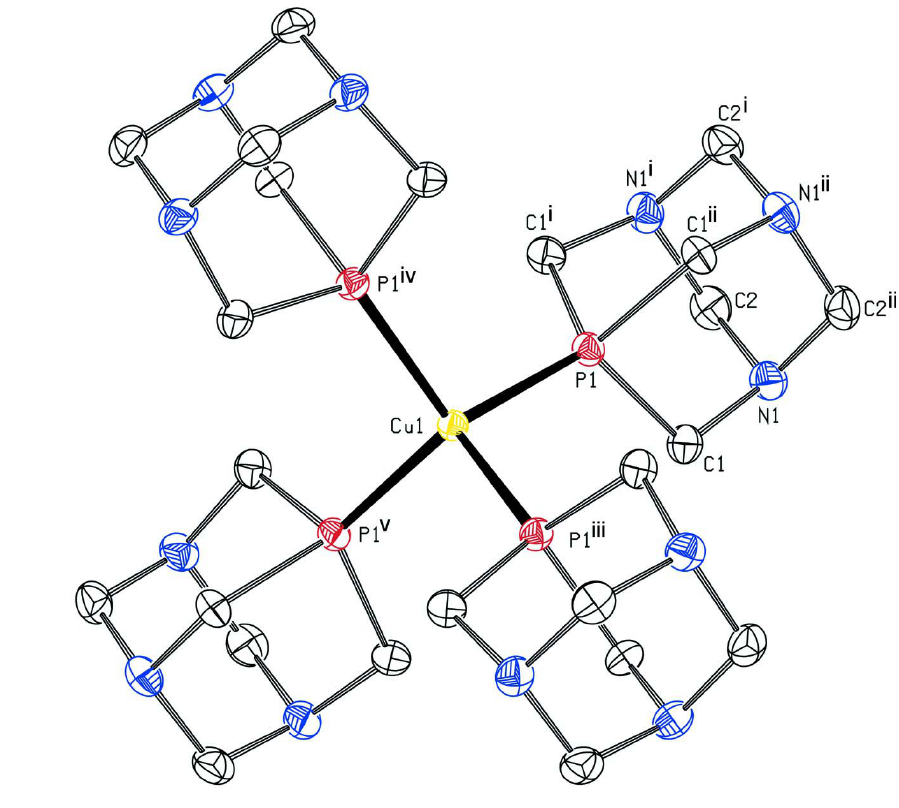
Molecular view of the cation with the atom-labelling scheme. Displacement ellipsoids are drawn at the 50% probability level. Hydrogen atoms are omitted for clarity. [Symmetry codes: (i) z, x, y; (ii) y, z, x; (iii) -x+1/4, y, -z+1/4; (iv) -x+1/4, - y+1/4, z; (v) x, -y+1/4,